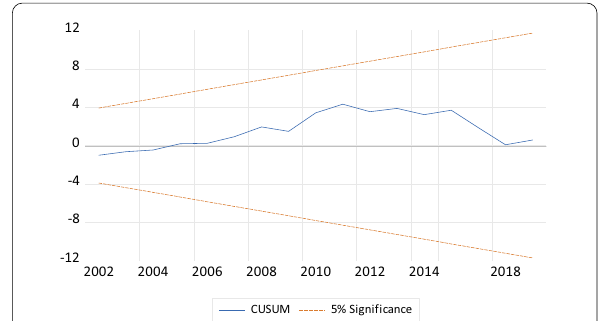
Fig. 4 Plot of cumulative sum of recursive. Source Generated by the author using Microfit 4.1